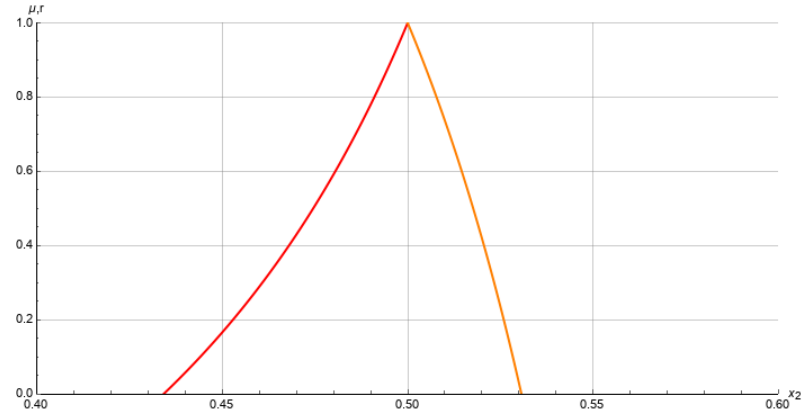
Figure 5. Solution X 2 of the benchmark Equation (9) achieved with the use of a standard approach based on Newton’s methods presented in